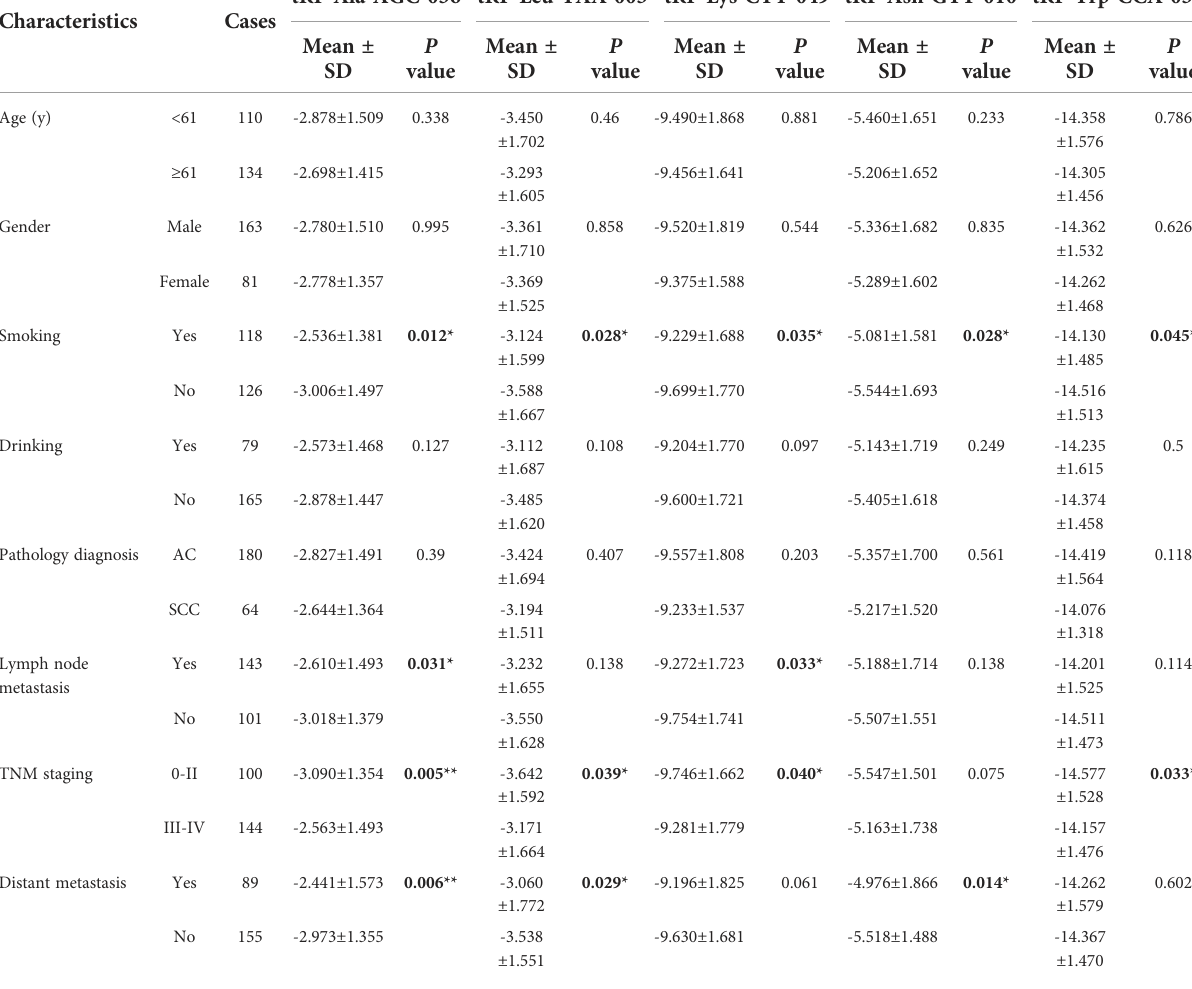
TABLE 1 Characteristics of NSCLC patients for differentially expressed plasma exosomal